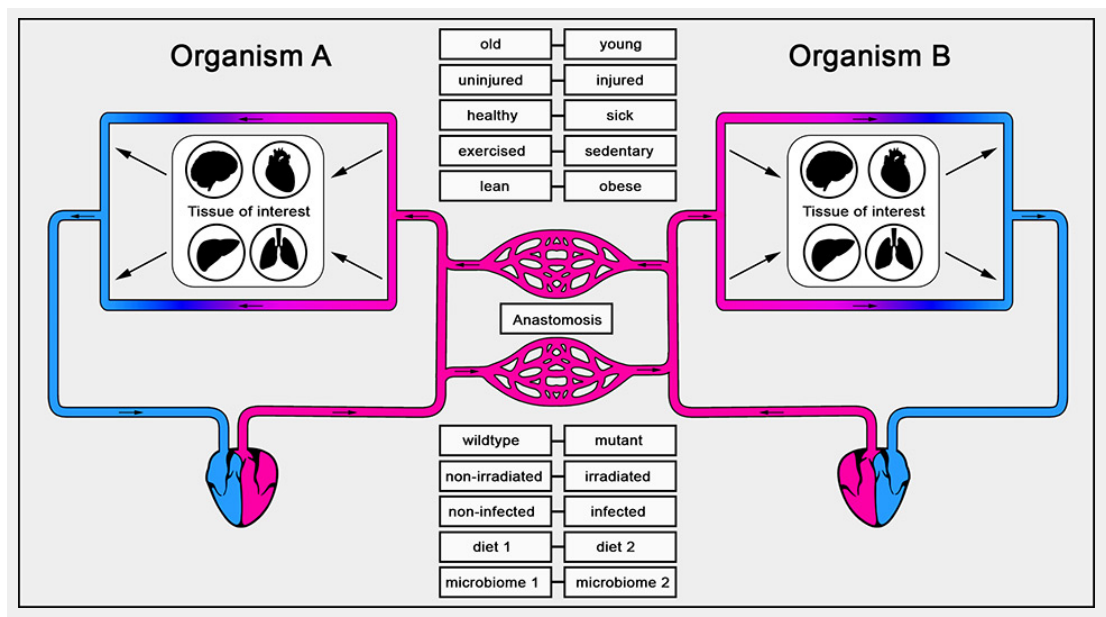
Figure 2 Circulatory system in parabiosis. Organism A and B share a common blood supply, which spontaneously develops through anastomosis after surgery. Organisms with different physiological conditions may be used for parabiosis in order to assess the systemic effect of one organism on a particular tissue of interest in its attached